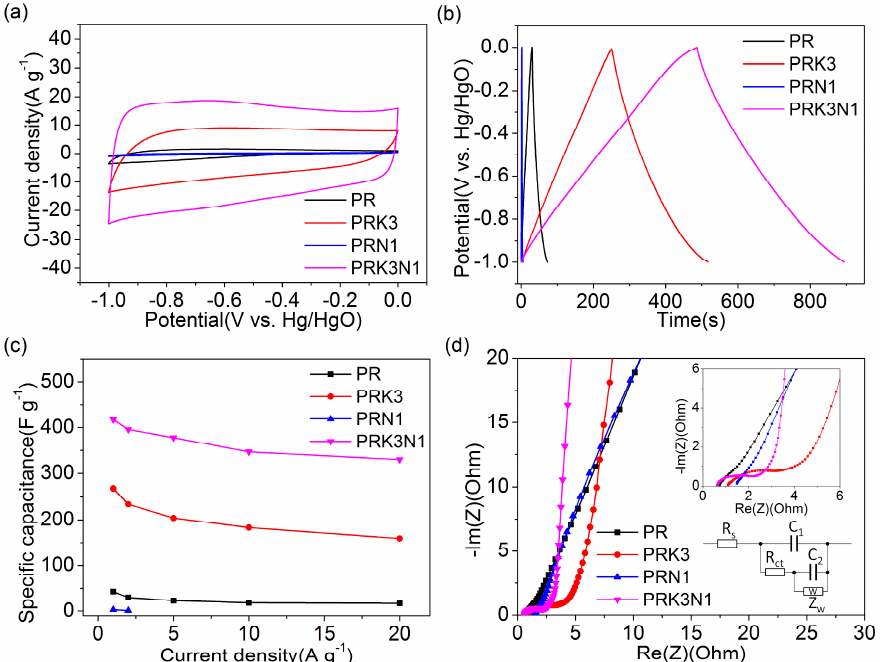
Figure 6. The electrochemical properties of all samples measured in a three-electrode system: ( a ) the CV curves of PR, PRK3, PRN1 and PRK3N1 at 50 mV·s − 1 ; ( b ) the GCD curves of PR, PRK3, PRN1 and PRK3N1 at 1 A·g − 1 ; ( c ) the specific capacitances of PR, PRK3, PRN1 and PRK3N1 at different current densities; ( d ) the Nyquist plots of all samples. The inset window shows the equivalent circuit and an enlarged view at high frequency.